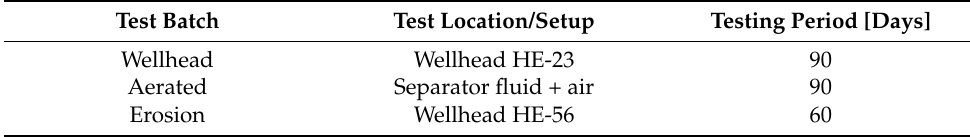
Table 3. Test locations and the relevant testing